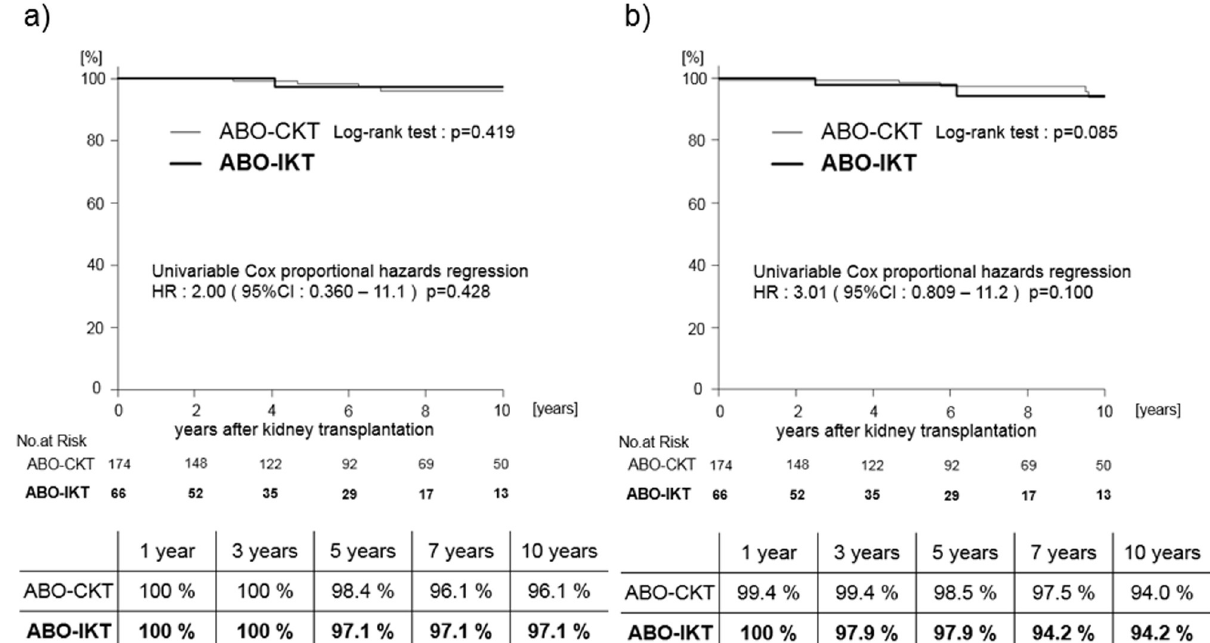
Fig 3. Patient and graft survival rates of ABO-CKT and ABO-IKT before propensity score matching. (a) Patient survival rates (b) Graft survival rates. ABO-CKT; ABO-compatible kidney transplantation, ABO-IKT; ABO-incompatible kidney transplantation.